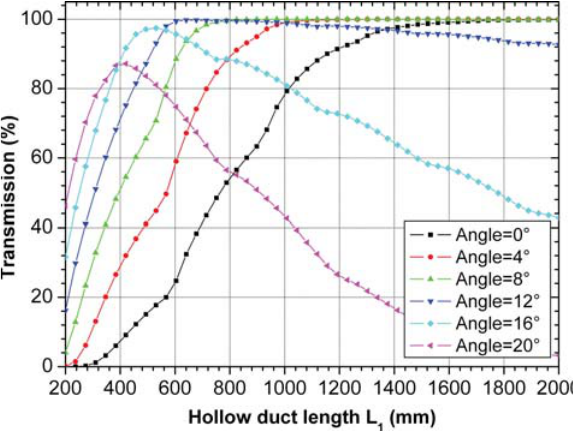
Fig. 6. Hollow-duct transmission as a function of its length L 1 for di ff erent values of laser-diode emission angles ϕ ; reflection losses from the sidewalls are not taken into account. performed for 3D model in commercial software ZEMAX